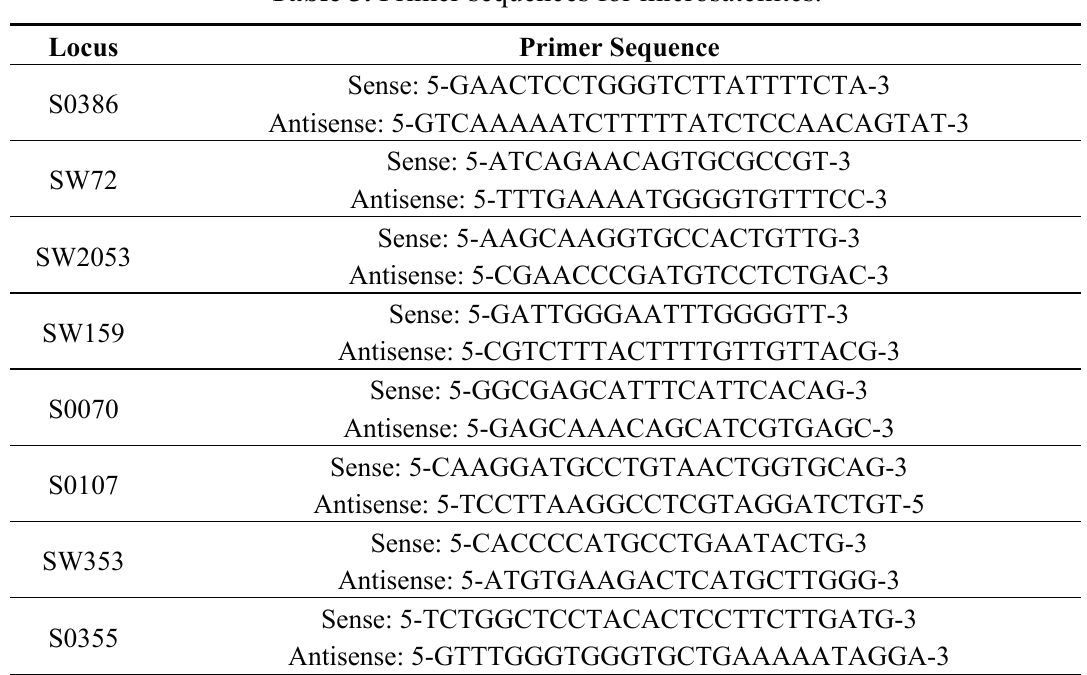
Table 3. Primer sequences for microsatellites.